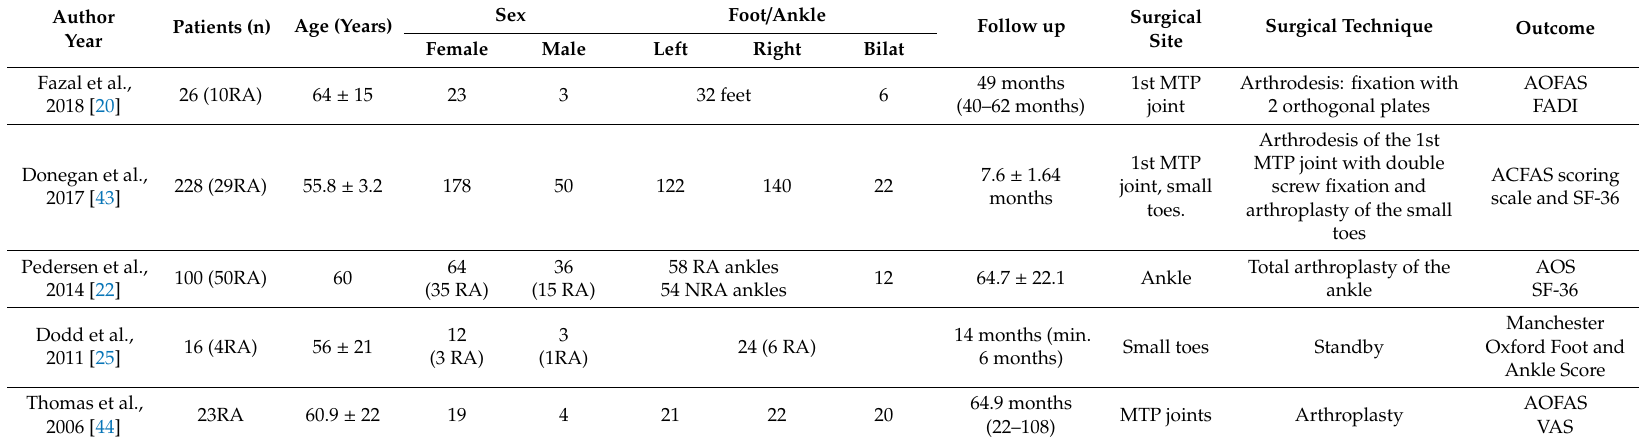
Table 2. Characteristics of cohort